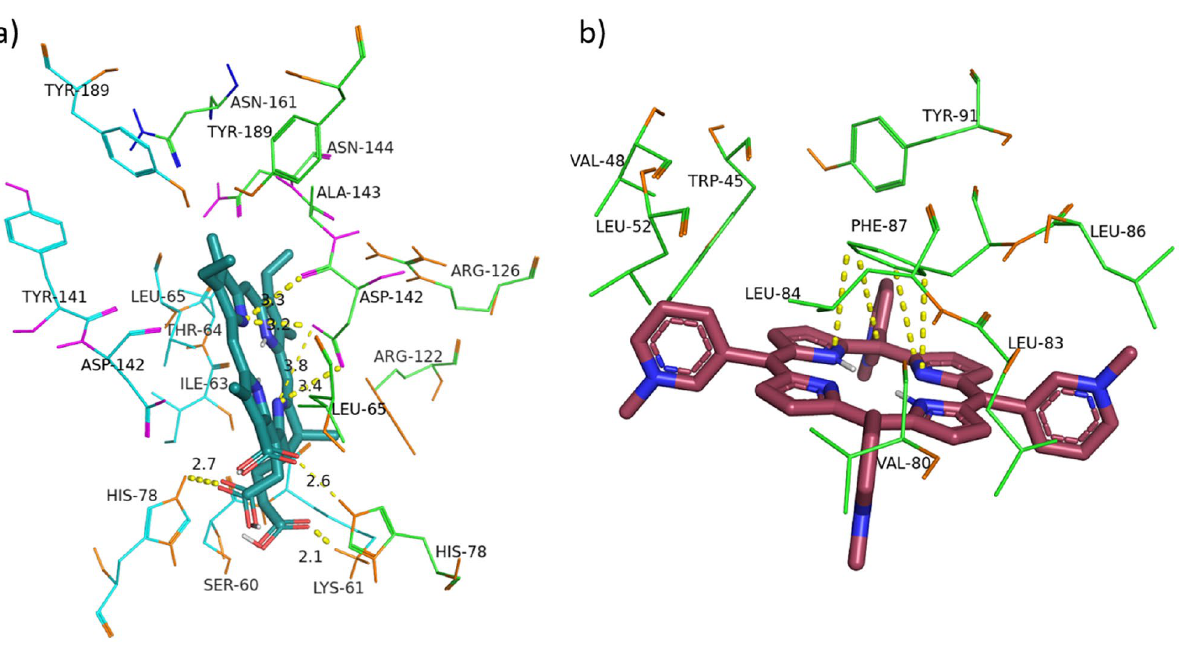
Figure 3. The complexes of Chlorin e6, complex 2 ( a ) and Chlorin, complex 1 ( b ) with dimer of ORF3a, chain A—green, chain